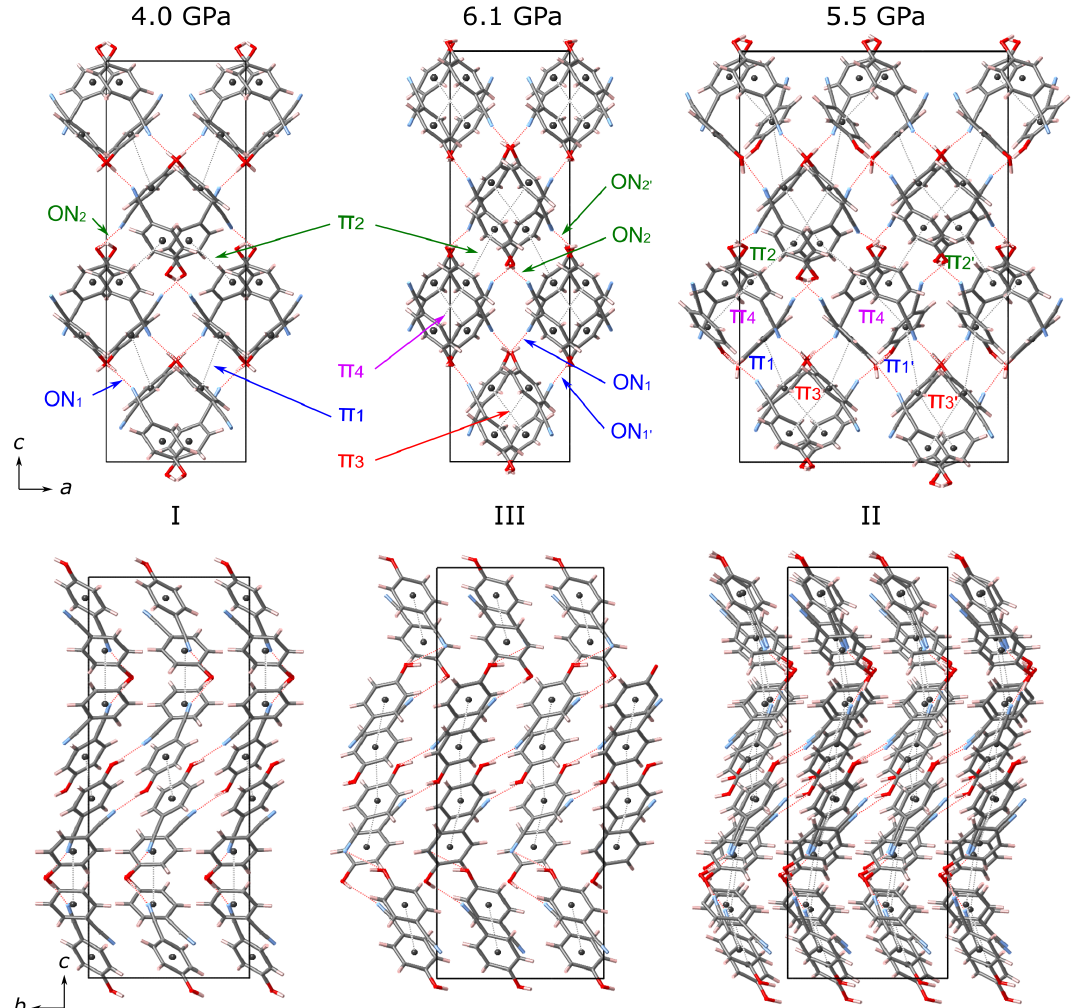
Figure 7. Structures of 4HCB compressed in neon for the ambient ( I ) and second high-pressure phases ( III ) with their intermolecular interactions indicated for possible π − π and hydrogen bonding (ON) interactions. The labels and colours of the indicated interactions relate to the same markers used in Figure 8. The first high-pressure phase ( II ) is also shown on the right. The dotted grey lines show possible π − π interactions between the centroid positions of the benzene rings (dark grey spheres), and the dotted red lines show the O · · · N distances involved in hydrogen bonding